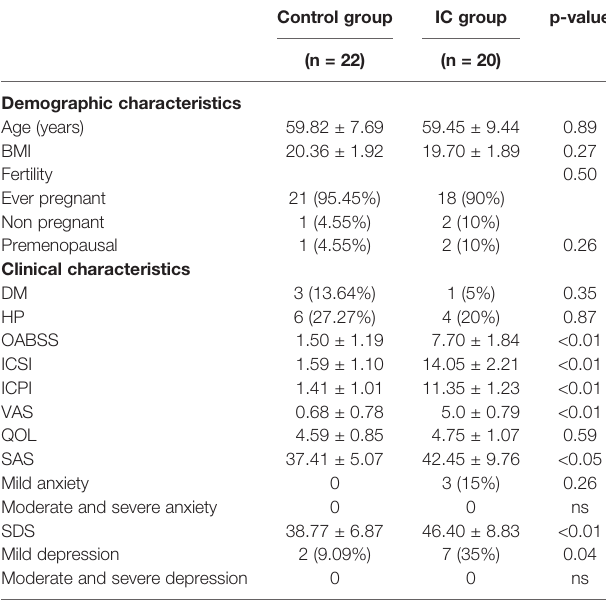
TABLE 1 | Demographic and clinical characteristics of IC patients and